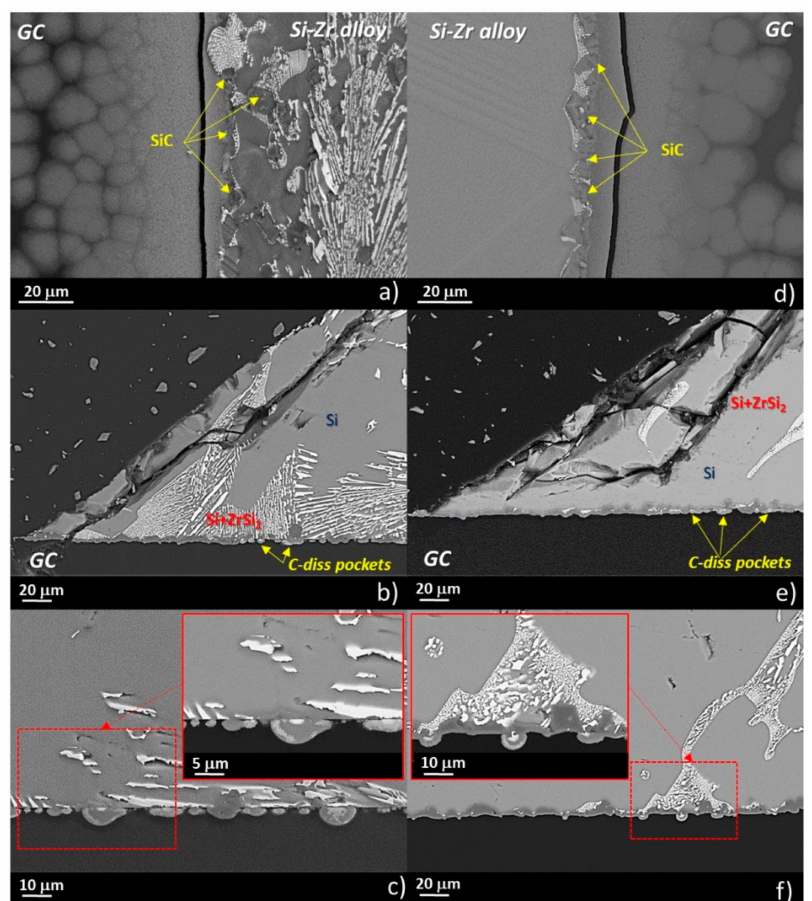
Figure 6. SEM-BSE and proposed phase identification by EDS analyses that were performed at di ff erent magnifications at the triple lines and at the interfaces of ( a ), ( b ), and ( c ) the Si-15Zr / GC sample; and ( d ), ( e ), and ( f ) the Si-5Zr sample after the wetting tests that were performed at T = 1450 ◦ C for 15